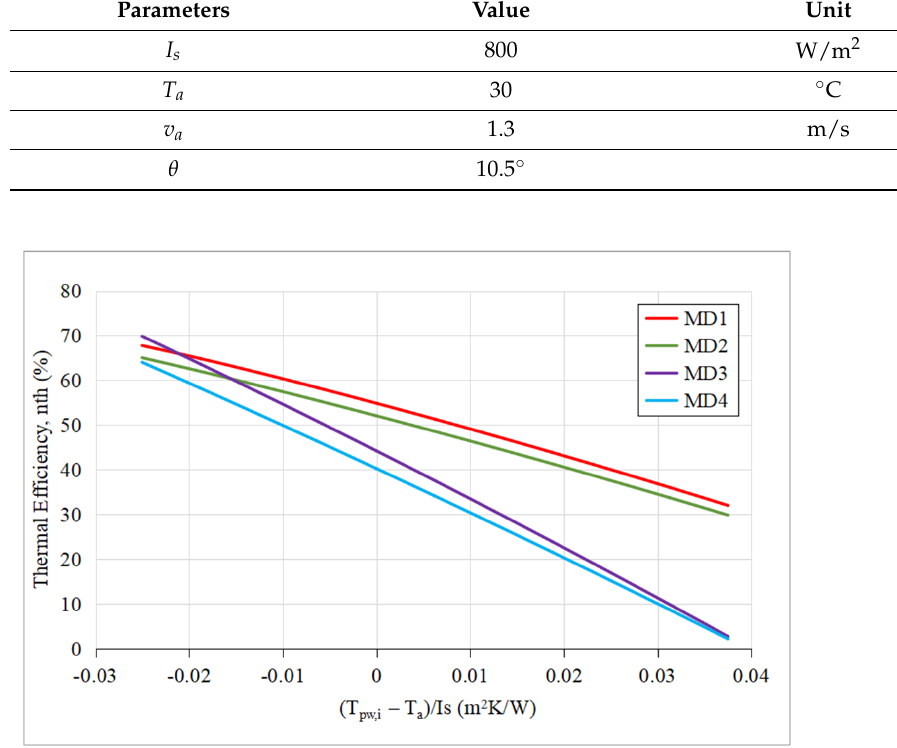
Figure 15. Thermal efficiency of four PV/T module models.